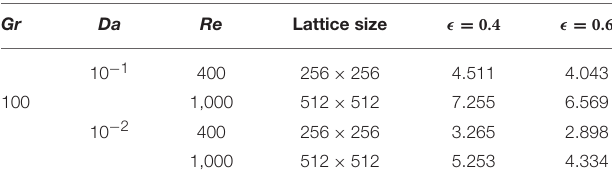
256 4.511 4.043 × 512 7.255 × 256 × 512 ×